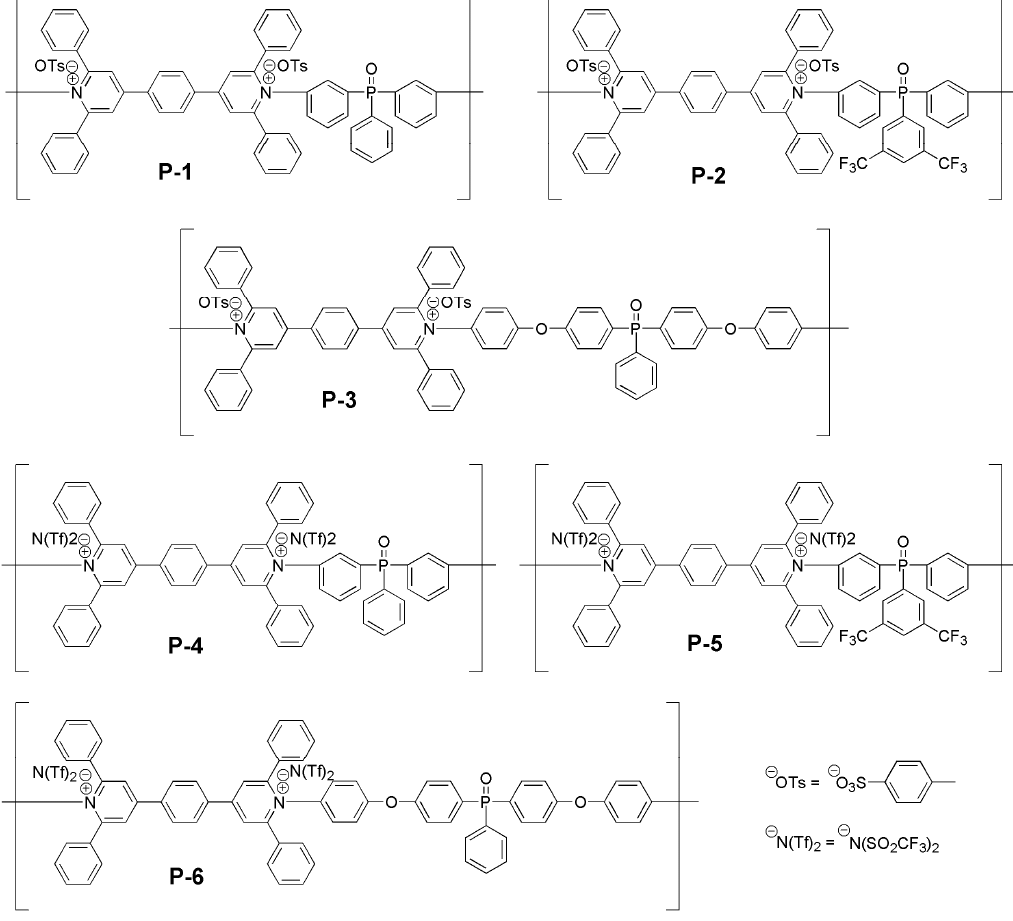
Figure 1. Chemical structures of rugged high temperature tolerant phosphine oxide-containing poly(4,4 ′ -( p -phenylene)- bis (2,6-diphenylpyridinium)) polymers P-1 to P-6 .